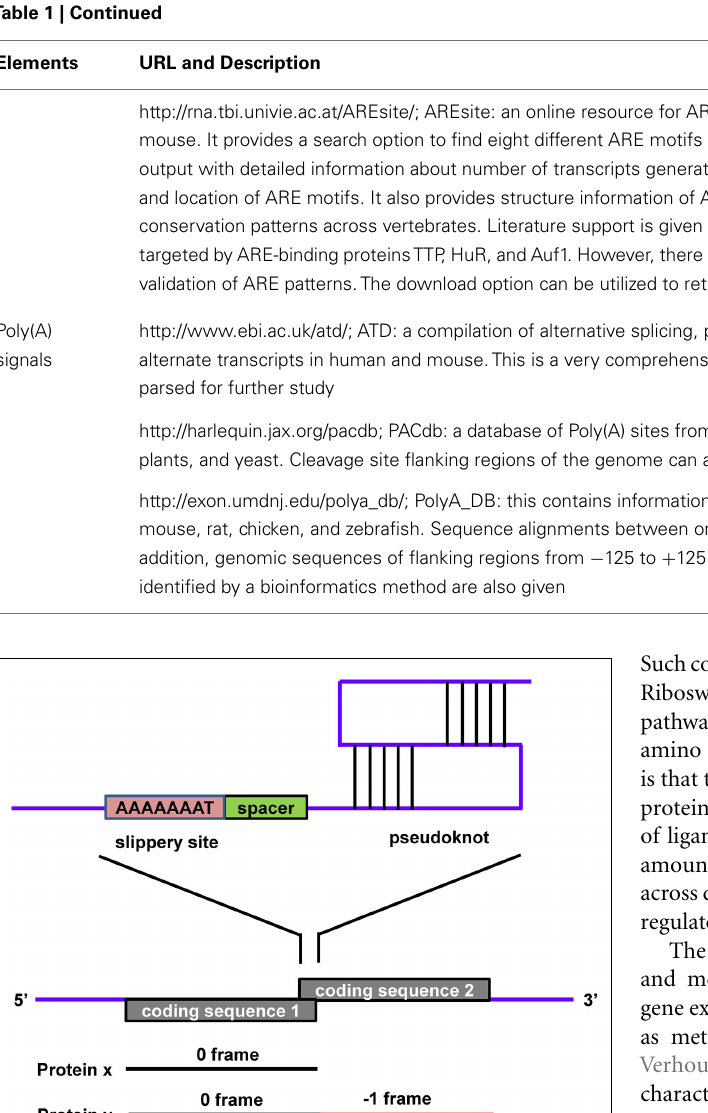
in the 5 (cid:2) -UTR, forms a secondary structure where the ligand is